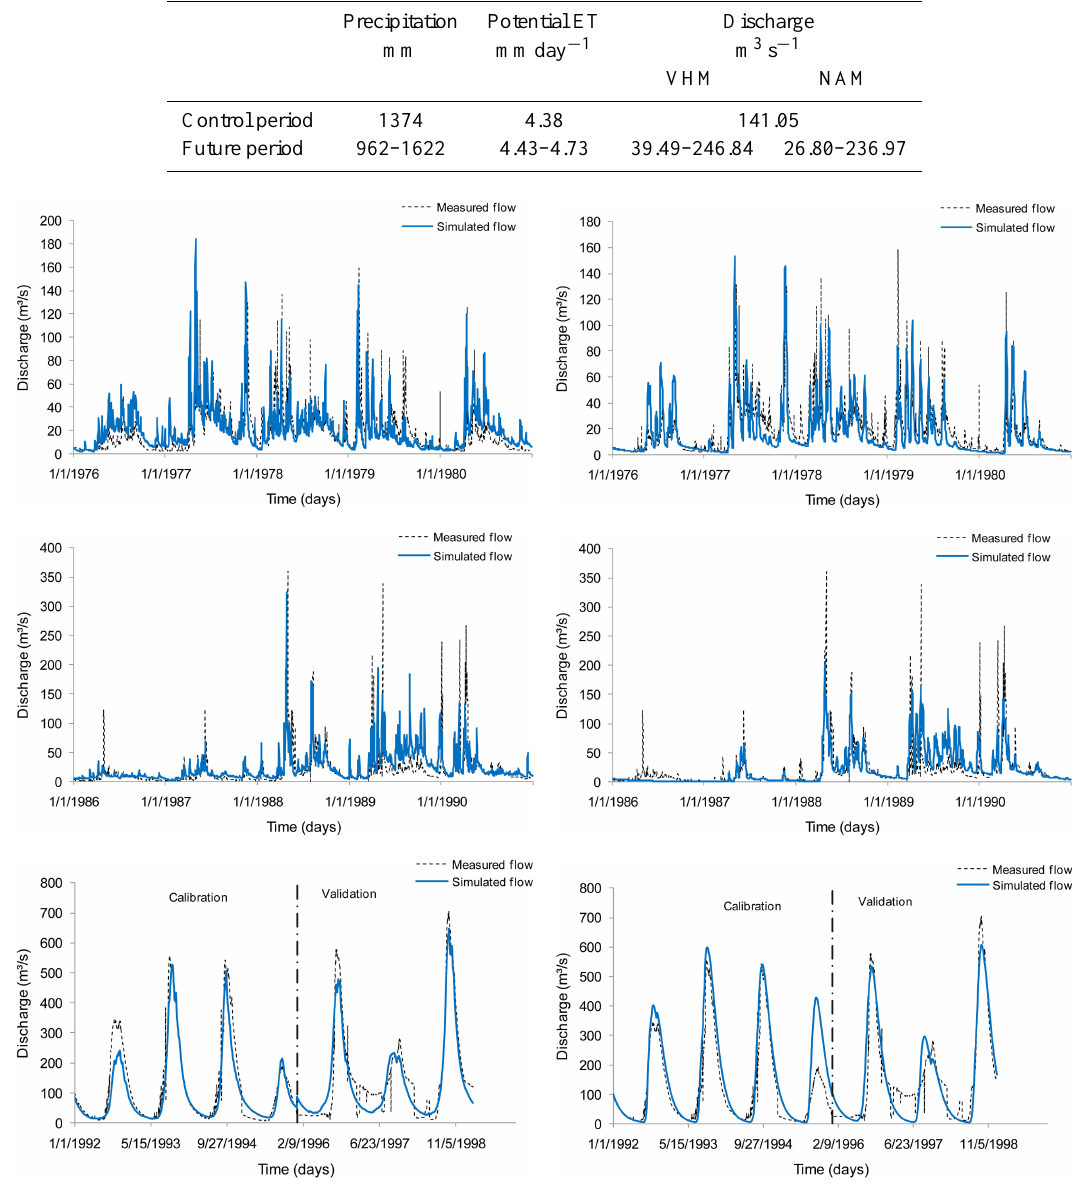
Fig. 4. Calibration and validation time series plots using VHM (left) and NAM (right) models for Nyando and Lake Tana catchment. Calibration of Nyando (top), validation of Nyando (middle) and both calibration/validation of Lake Tana